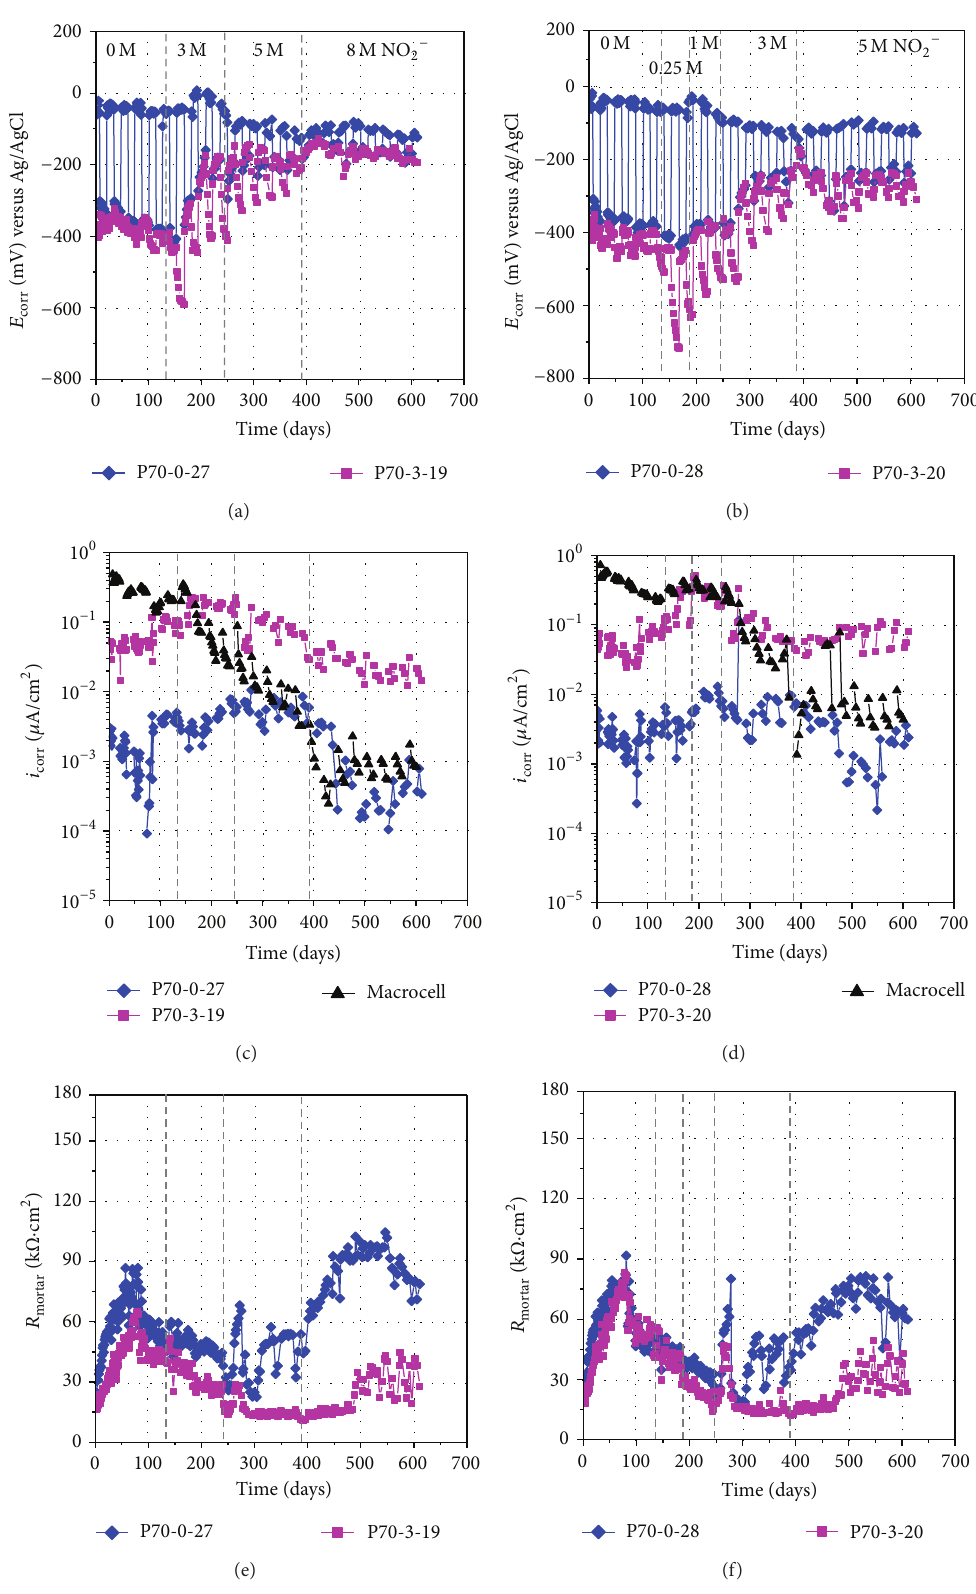
Figure 3: Time evolution curves of half-cell potential, microcell current density, macrocell current density, and resistance of mortars. (a) Half-cell potential of steel in Case N1, (b) half-cell potential of steel in Case N2, (c) corrosion current density of steel in Case N1, (d) corrosion current density of steel in Case N2, (e) resistance of mortar in Case N1, and (f) resistance of mortar in Case